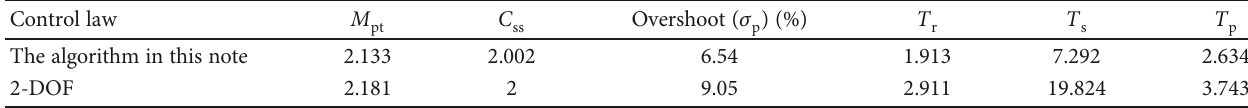
Table 3: Parameters of liquid cargo tanks for thermal load